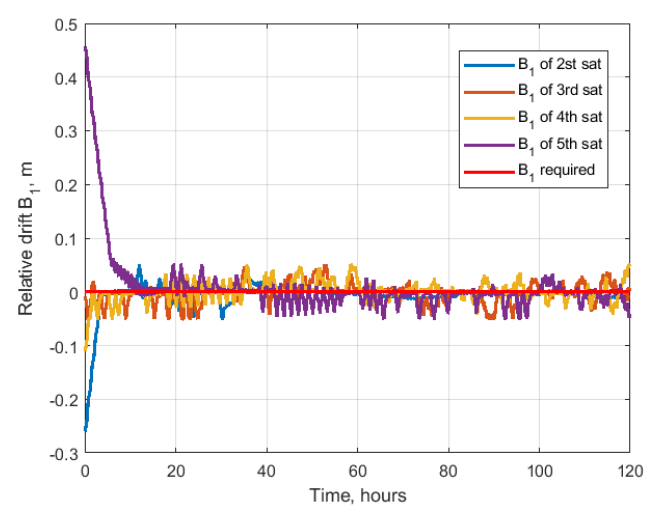
Figure 26. Relative drift.